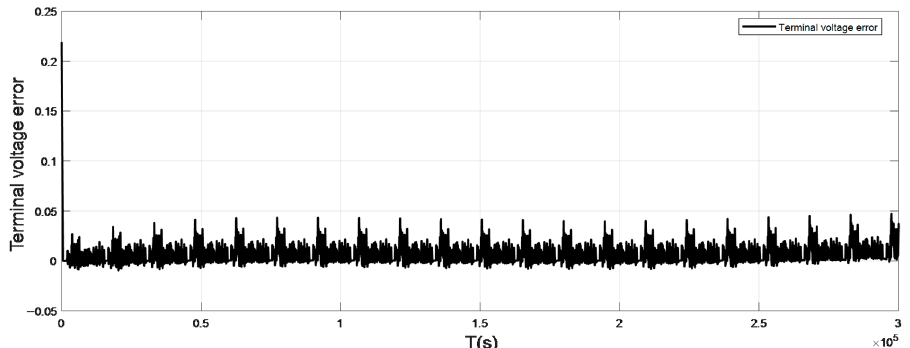
Figure 4. Terminal voltage error curve at 25°C.